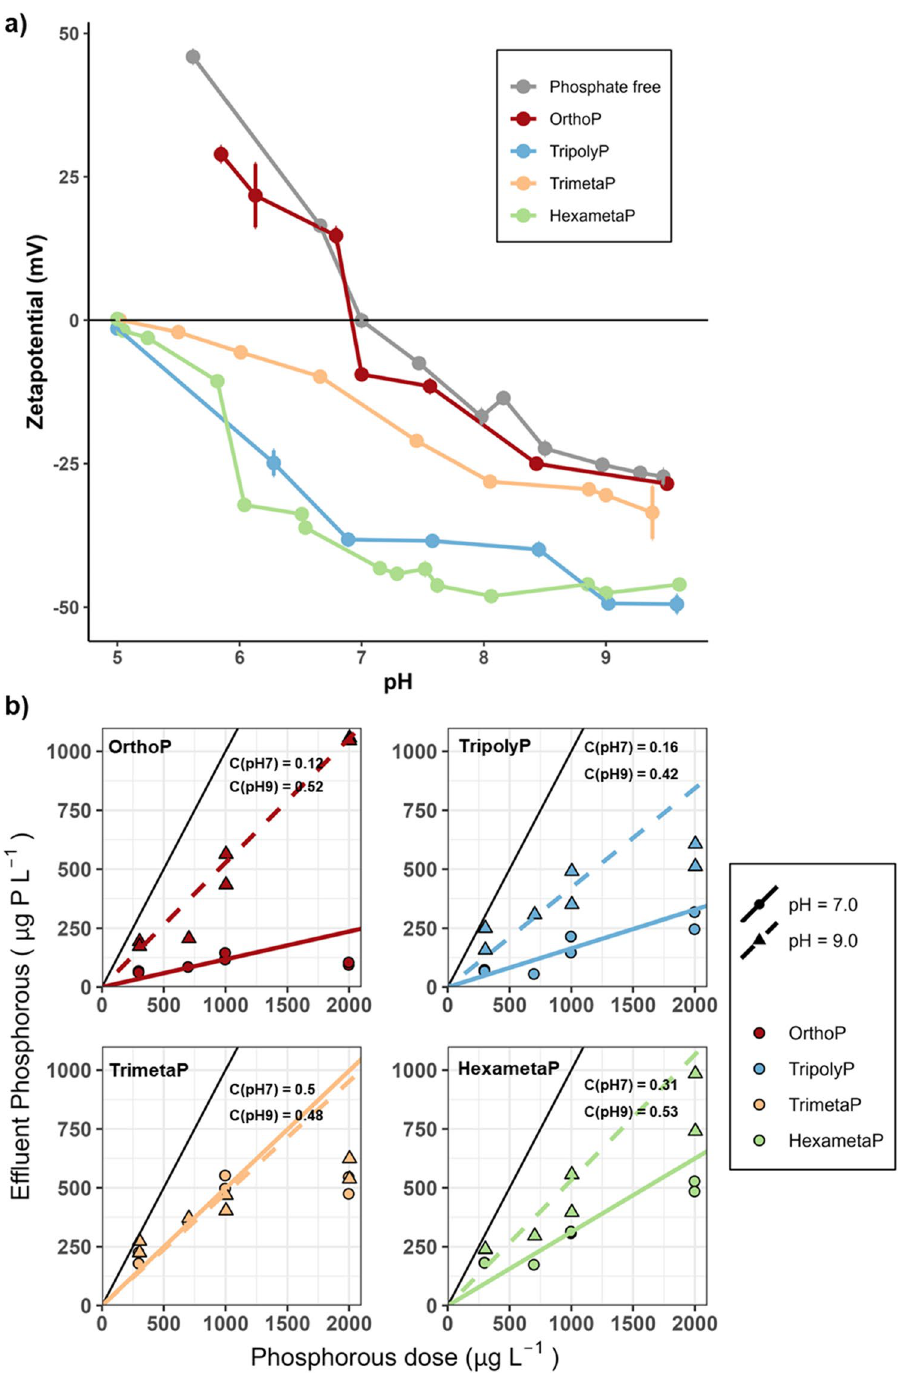
Figure 5. ( a ) Zetapotential (pH = 5.0–9.5, P = 0 or 1000 µg P L −1 ), ( b ) phosphorus adsorption (pH = 7.0 or 9.0, P = 0–2000 µg P L −1 ) by lead carbonate as a function of pH and phosphate type (OrthoP, TripolyP, TrimetaP, HexametaP) at DIC 5 mg C L −1 from the batch experiment. Each set represents at least two reactor runs, and error bars span the median absolute deviation of measurements. Colored lines (representing y = Cx) are labeled by their corresponding C, where C is the estimated fraction of total phosphorus remaining in solution at the end of 30 min. The solid black line represents y = x. The estimates (C) were obtained by computing an additive difference estimate between the log-transformed influent and effluent phosphorus concentrations, resulting in a multiplicative estimate on the measurement